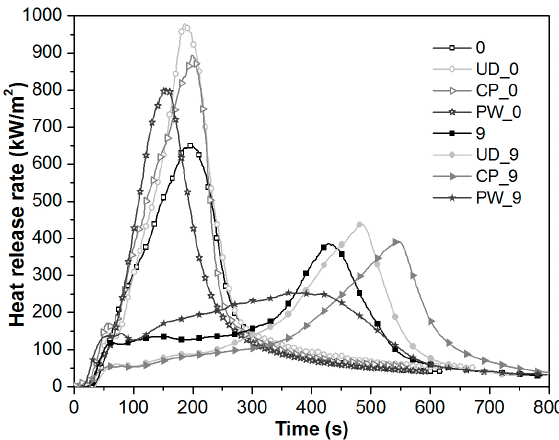
Figure 2. Heat release rate curves of non-reinforced and self-reinforced PP samples with flame retardant contents of 0 and 9 wt %.